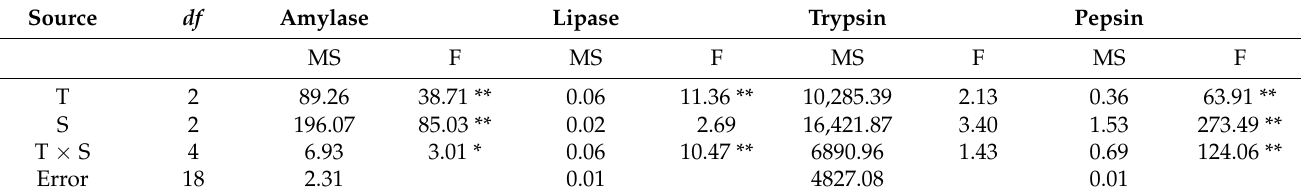
Table 4. MANOVA results using a generalized linear model for the main and interaction effects of temperature and salinity on Perna viridis digestive enzymes.